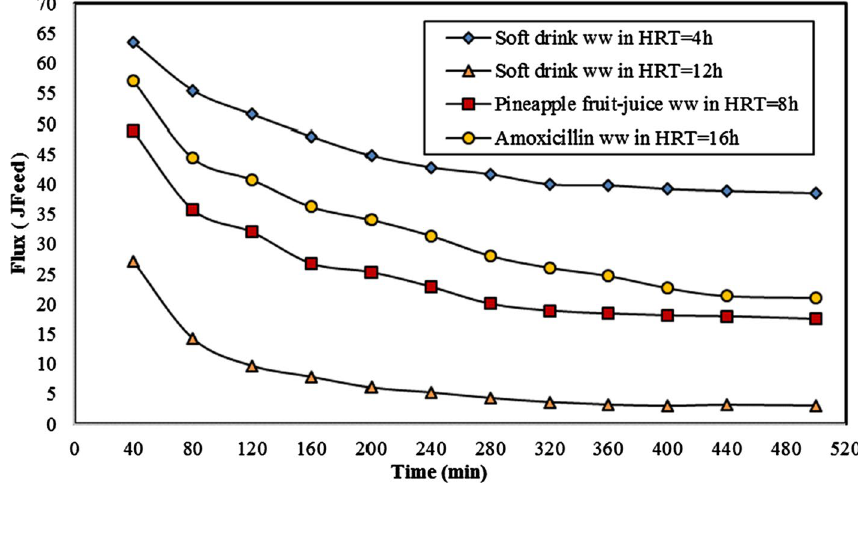
Fig. 10 The results of J ing long-term filtration in the UF membrane at constant pres- sure of 30 psi for three types of wastewater